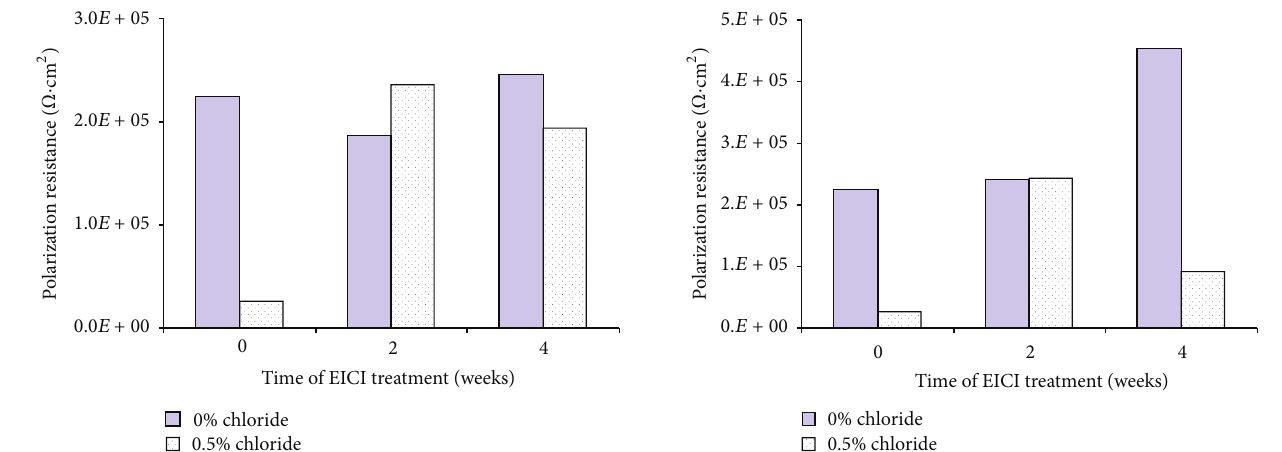
0% chloride 0.5% chloride Figure 11: Polarization resistance values for steel rebar embedded in chloride-contaminated cement mortar before and after EICI treatment in sodium hydroxide solution.